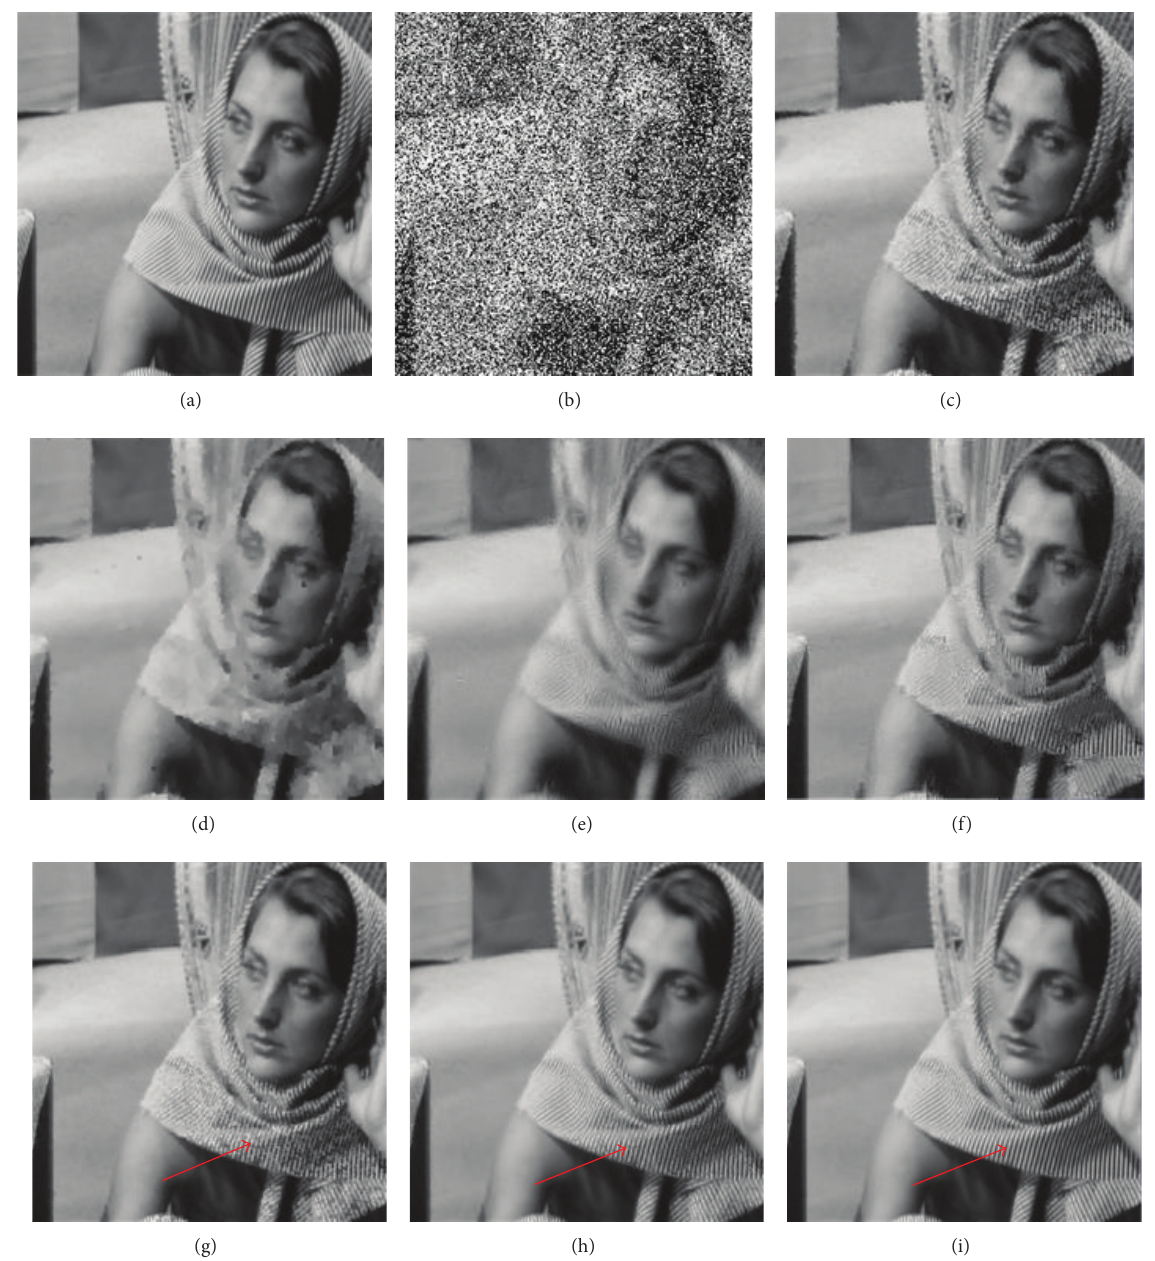
Figure 4: Reconstructed Barbara images from 50% salt and pepper impulse noise. (a) Noise-free image, (b) noisy image, and (c)–(i) reconstructed images using AMF, TV, Wavelet, PANO, TV-ND, Wavelet-ND, and PANO-ND, respectively.